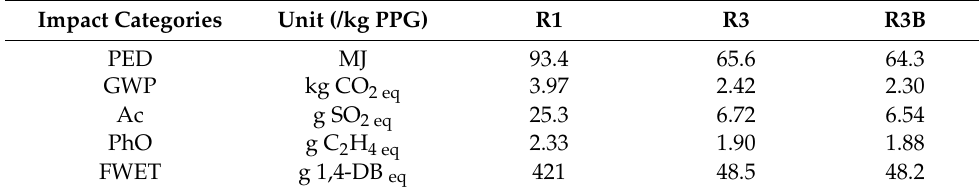
Table 8. PED and GWP performance obtained by R1, R3, and